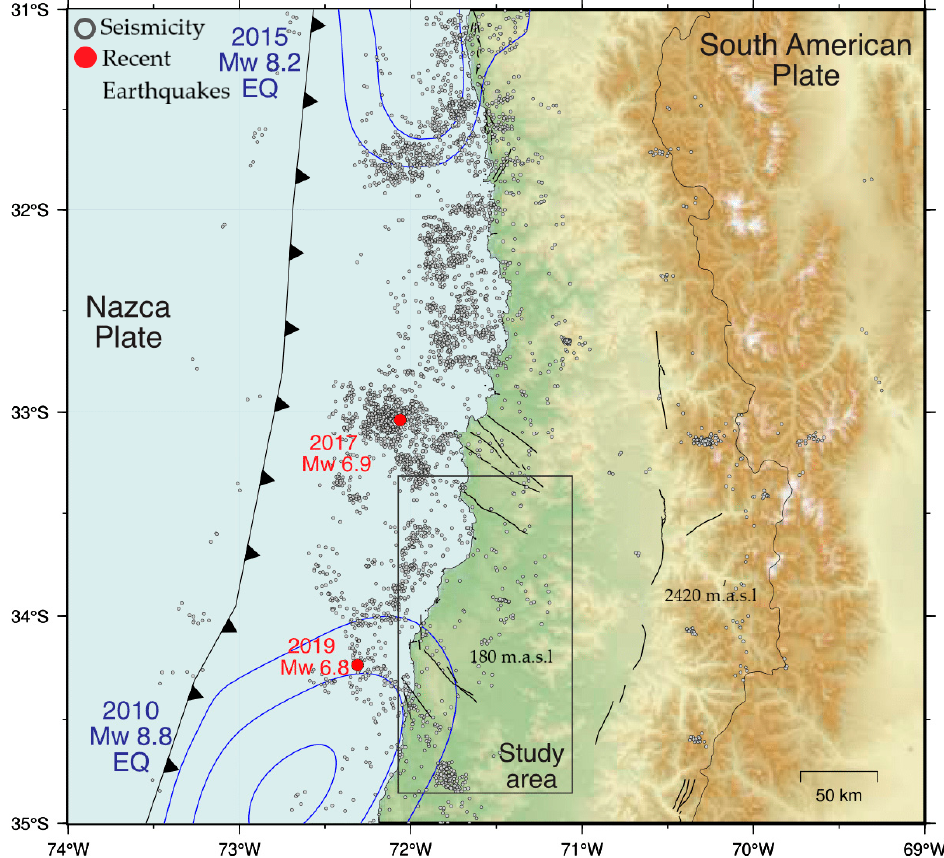
Figure 1. Tectonic setting of the study area. Blue contours indicate the slip of earthquakes that occurred in 2010 (Mw 8.8) and 2015 (Mw 8.2). Gray dots show background seismicity (earthquakes smaller than Mw 6.5) recorded in the study area between 2014 and 2018 [52]. Two earthquakes of magnitudes greater than Mw 6.5 have been recorded in recent years (red dots) [53].